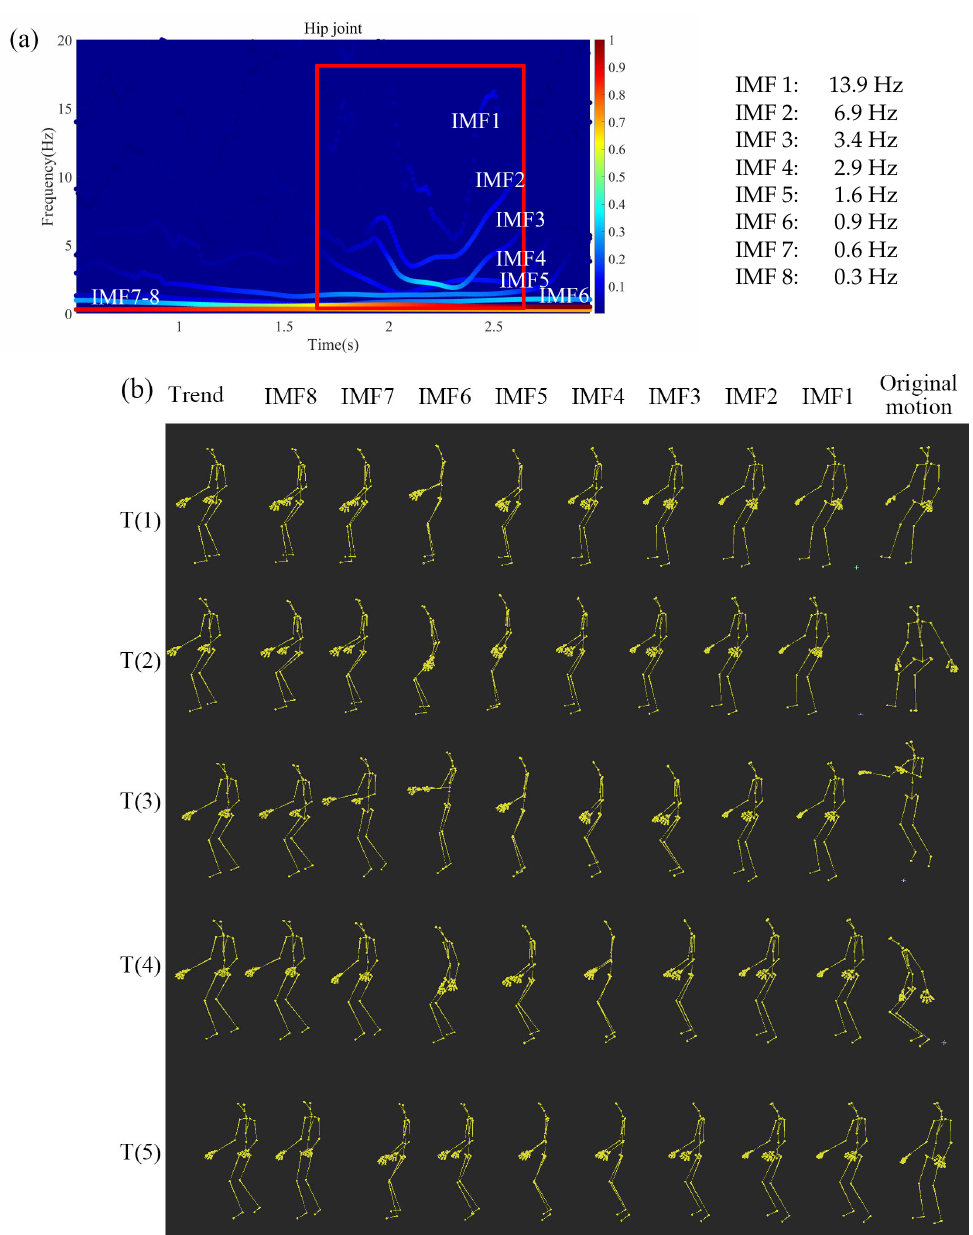
Figure 5. Decomposed jump motions using our proposed framework. ( a ) The Hilbert spectrum of the hip joint, and ( b ) each IMFs and the trend decomposed by MEMD. Here, T(1)–T(5) correspond to the time 0.5 s, 1.0 s, 1.6 s, 2.2 s, and 2.8 s. Table 3. The instantaneous frequency (Hz) of each decomposed IMF and its trend at the landing impact. IMF